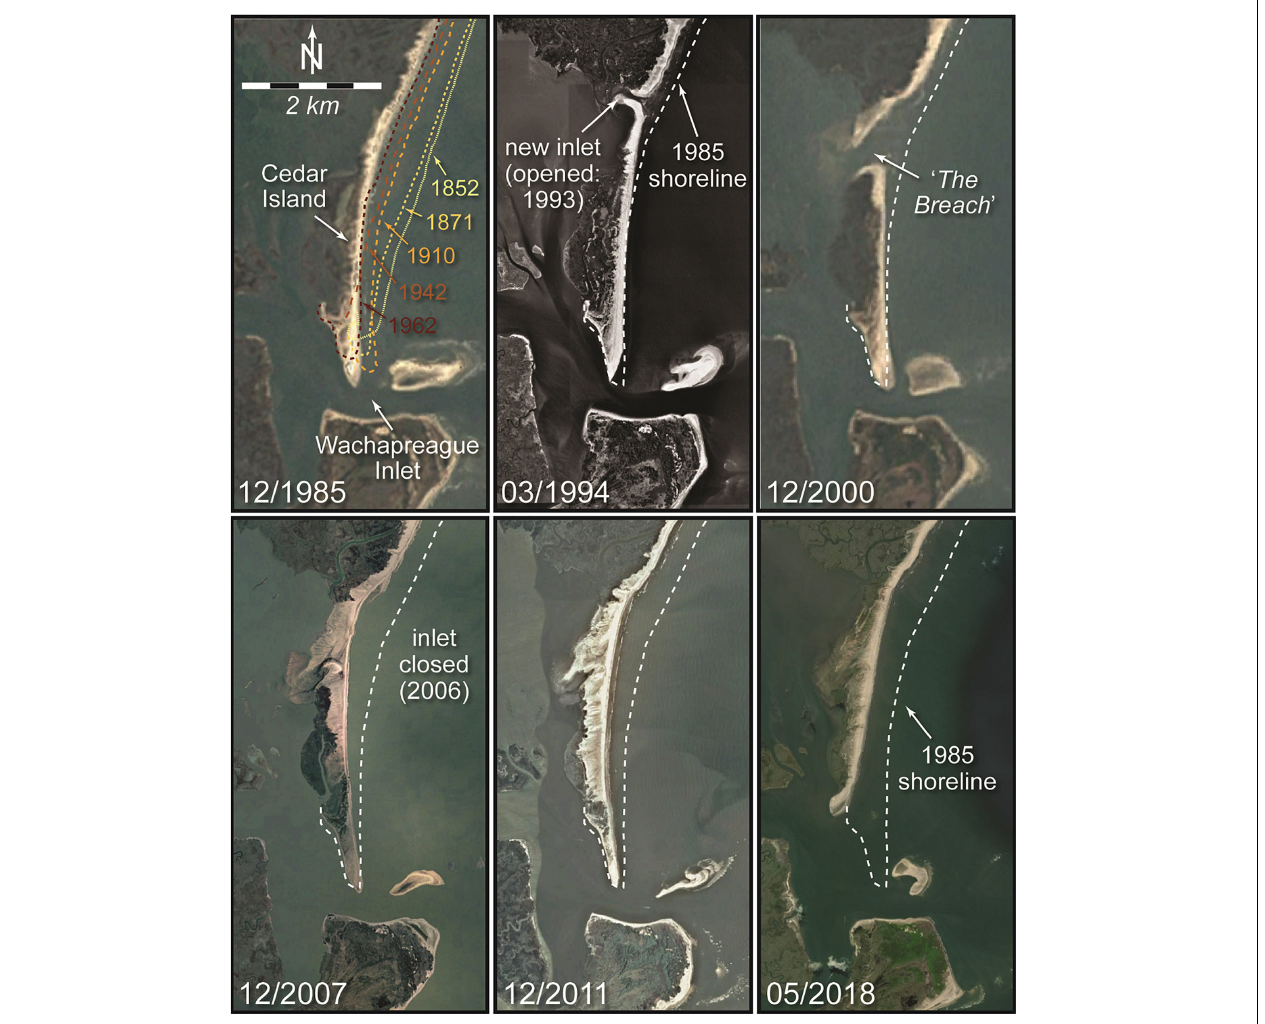
FIGURE 3 | Historic satellite orthoimagery from southern Cedar Island, showing physical change over a period of 33 years (1985–2018). Note the combination of former island breaching (1993–2006) and more recent shortening due to widening of Wachapreague Inlet (2011–2018). The marsh restoration site is located landward of the former inlet (locally called “The Breach”). Imagery sources: Landsat (1985, 2000), US Geological Survey (1994), the Commonwealth of Virginia (2007) and the National Agriculture Imagery Program of the US Department of Agriculture’s Farm Service Agency (2011, 2018). Historical shorelines overlain on 1985 image are from historical maps and NOAA t-sheets, digitized by Himmelstoss et al.